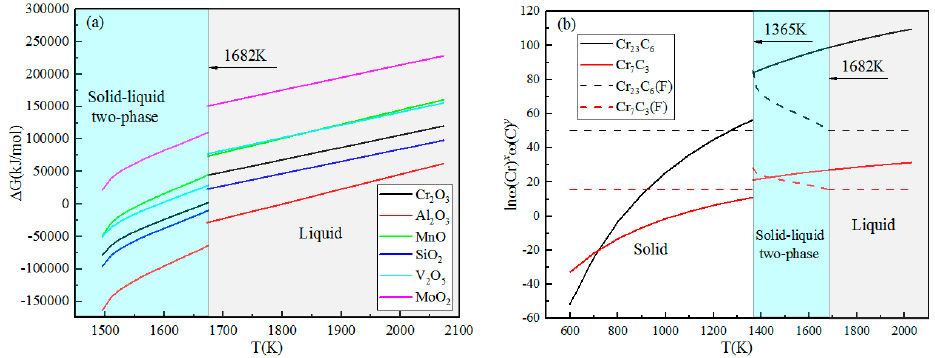
Figure 10. Precipitation thermodynamic calculation results: ( a ) oxides, ( b ) carbides.